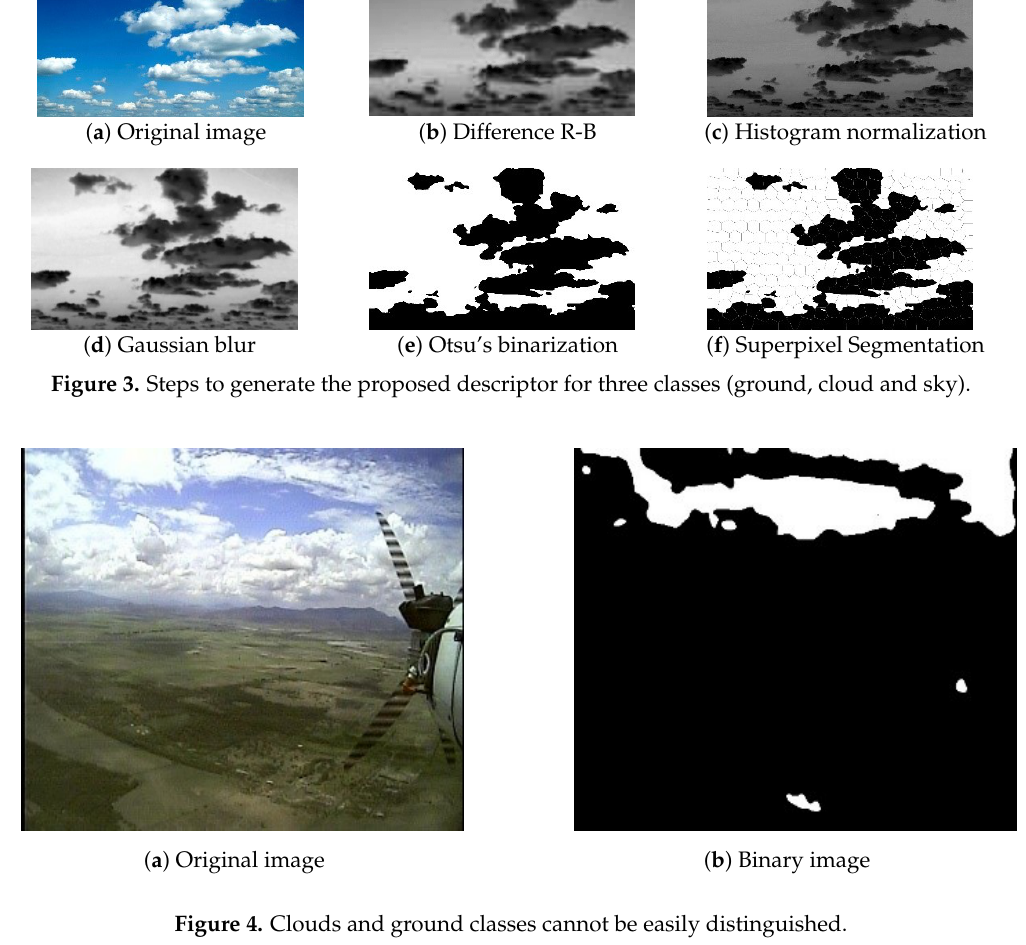
Figure 4. Clouds and ground classes cannot be easily